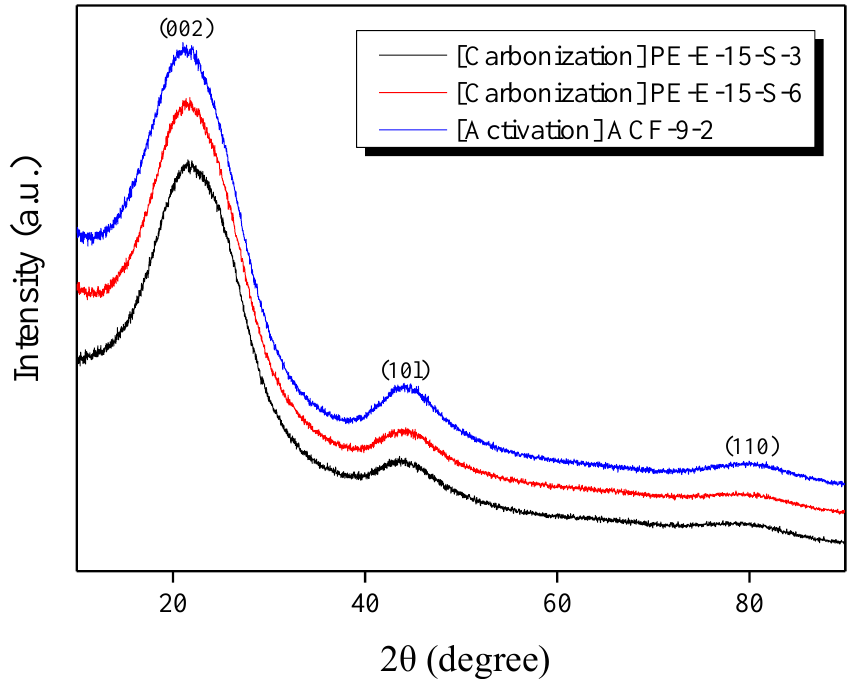
Figure 6. XRD patterns of hybrid-treated LLDPE fibers after carbonization (900 °C) and